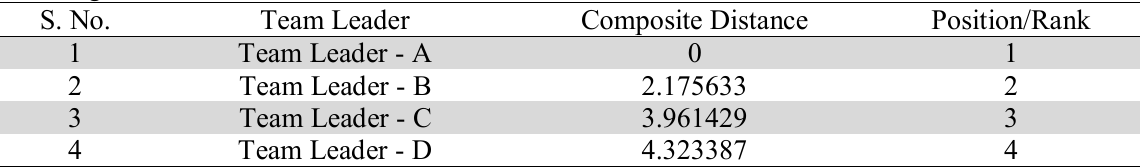
Rankings of Team Leaders obtained from EDBA